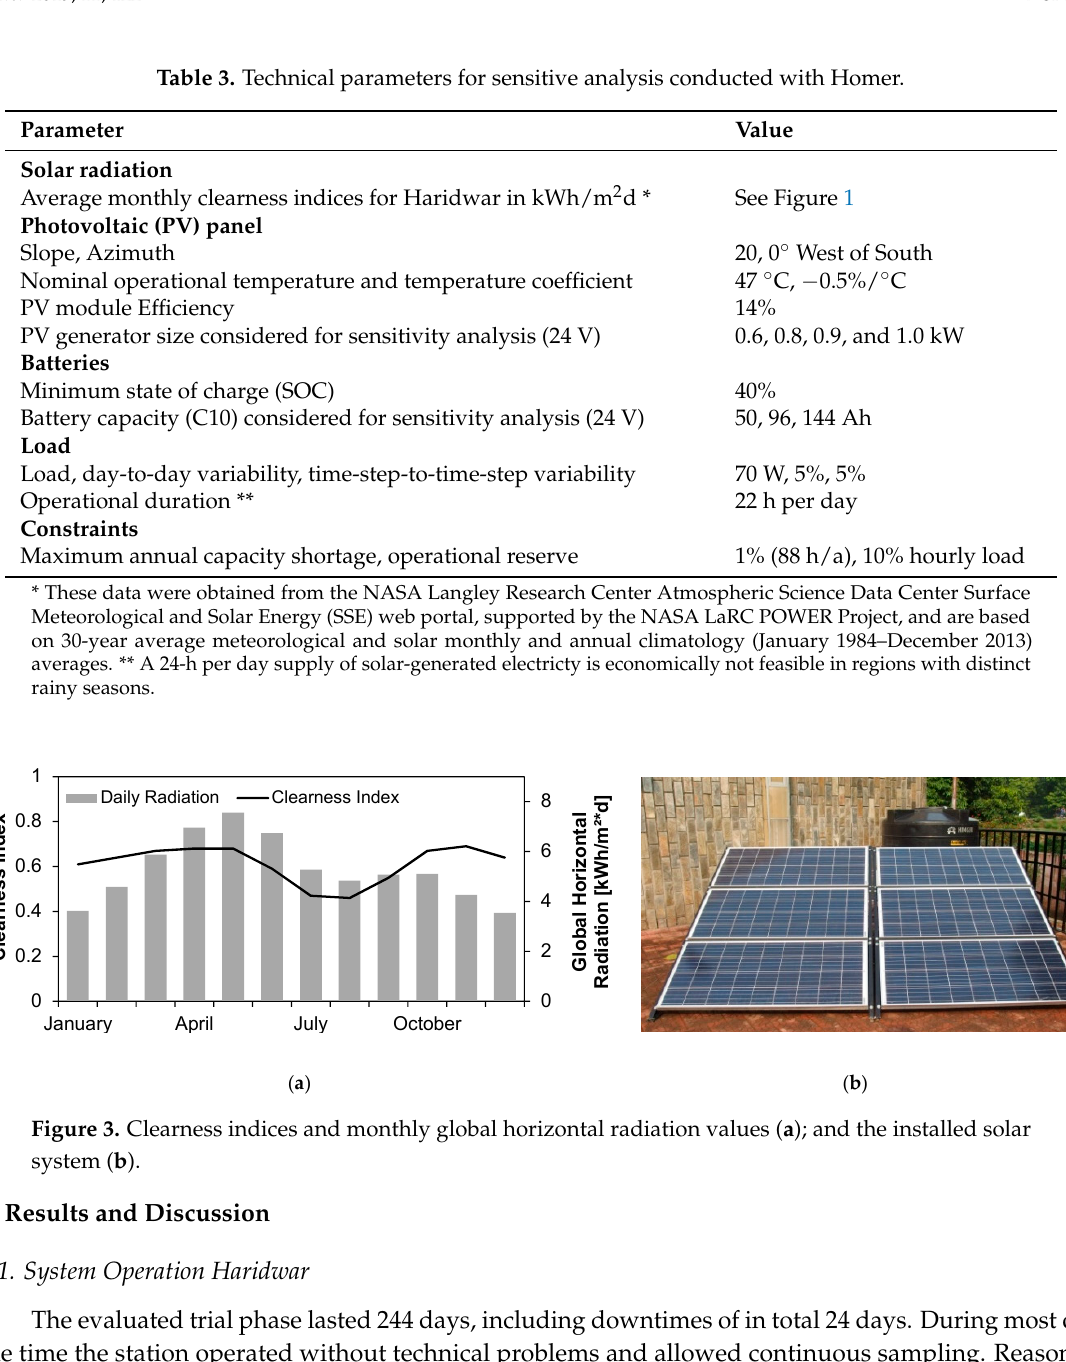
Table 3. Technical parameters for sensitive analysis conducted with Homer.